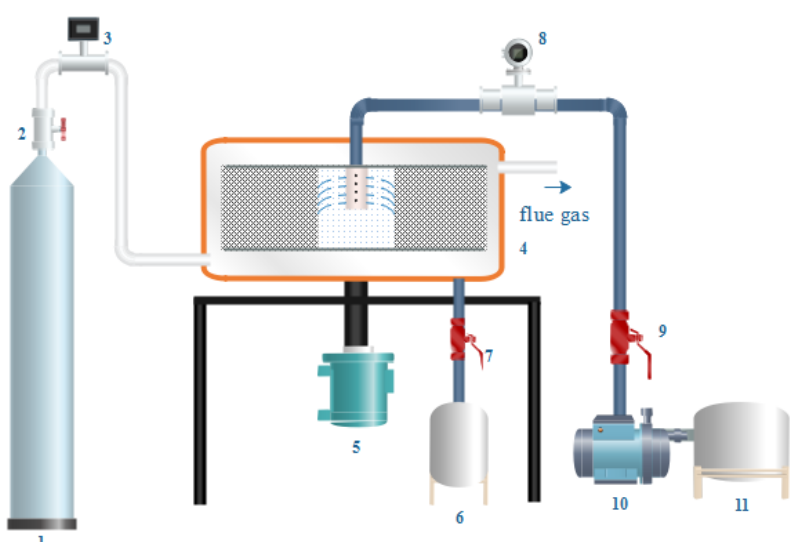
Figure 2. 1 — gas tank; 2, 7, 9 — valve; 3 — gas flow meter; 4 — cross-flow rotating packed bed; 5 — motor; Figure 2. 1—gas tank; 2, 7, 9—valve; 3—gas flow meter; 4—cross-flow rotating packed bed; 5—motor; 6, 11 — liquid storage tank; 8 — fluid flow meter; 10 — pump. 6, 11—liquid storage tank; 8—fluid flow meter;